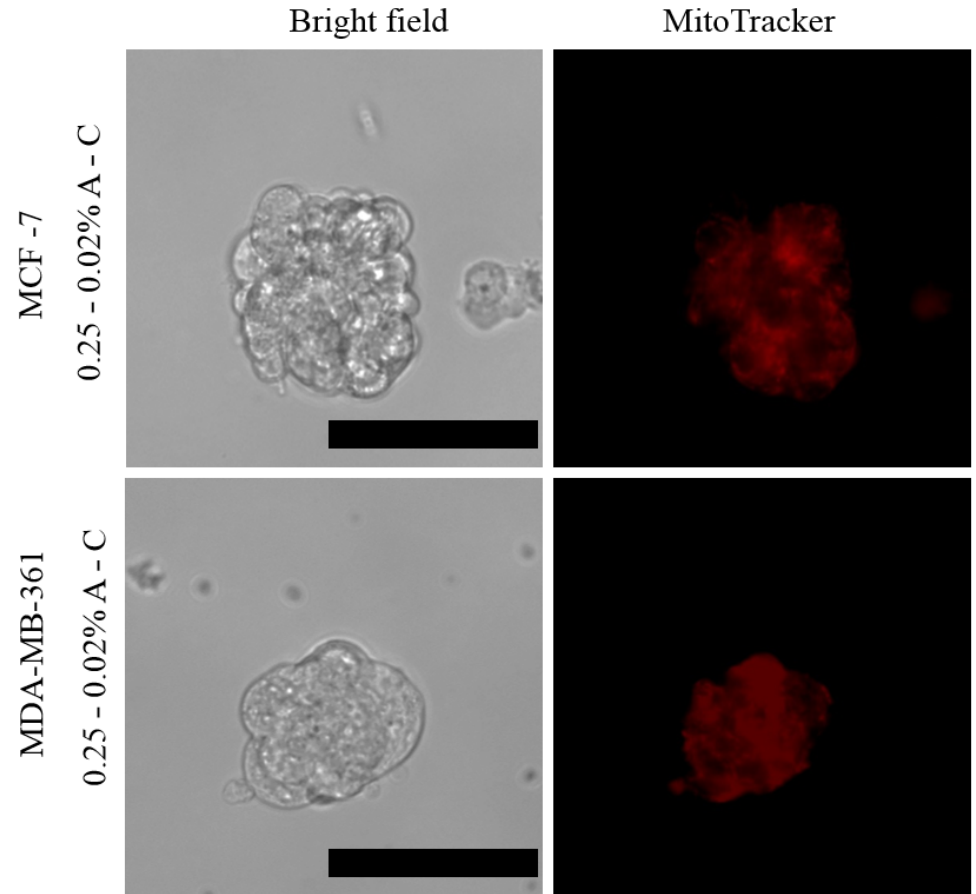
Figure 6. Mitochondrial labeling with MitoTracker red of living spheroids of MCF-7 and MBA-MB- 361 cells after 5 days of growth. Scale bar is 50 µm. 361 cells after 5 days of growth. Scale bar is 50 µ